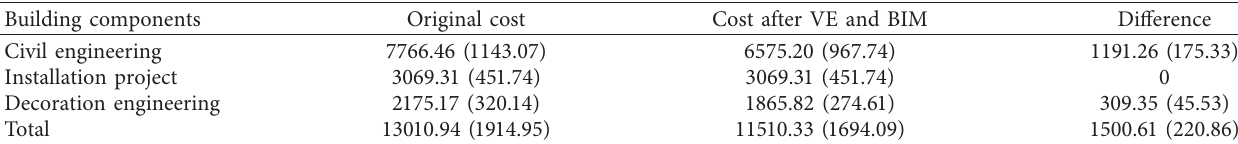
Table 11: Potential cost saving as a result of VE and BIM application in ten thousand RMB